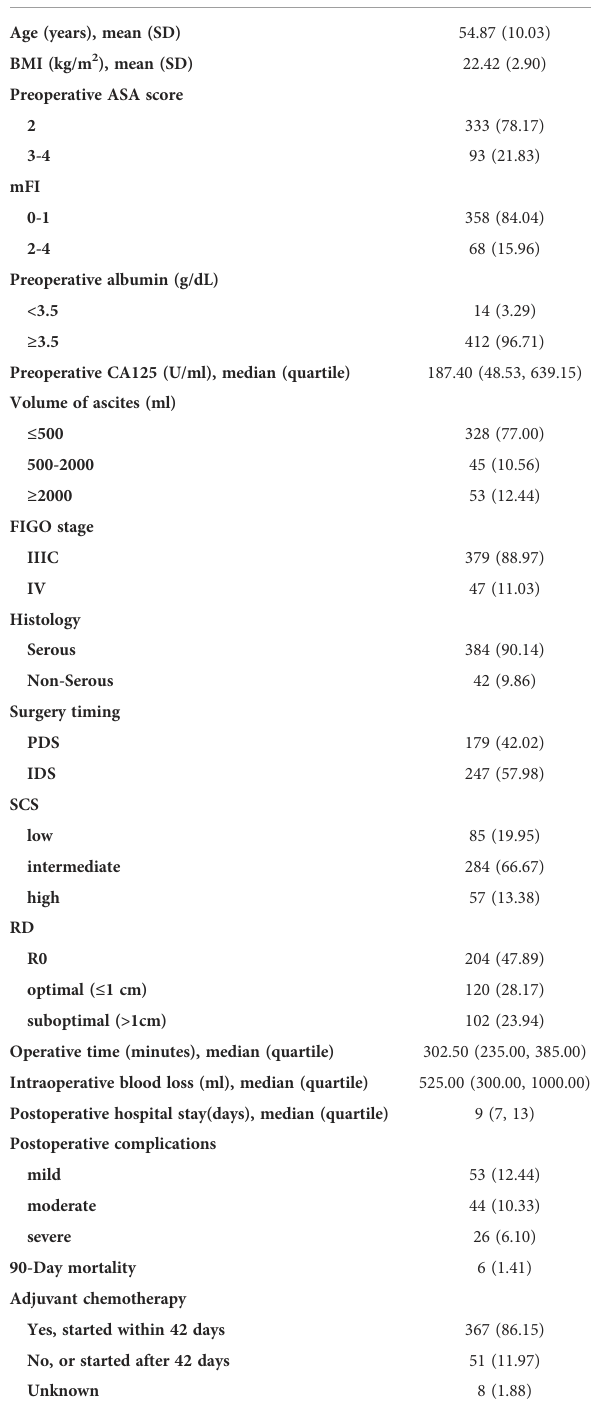
TABLE 1 Patients characteristics in training